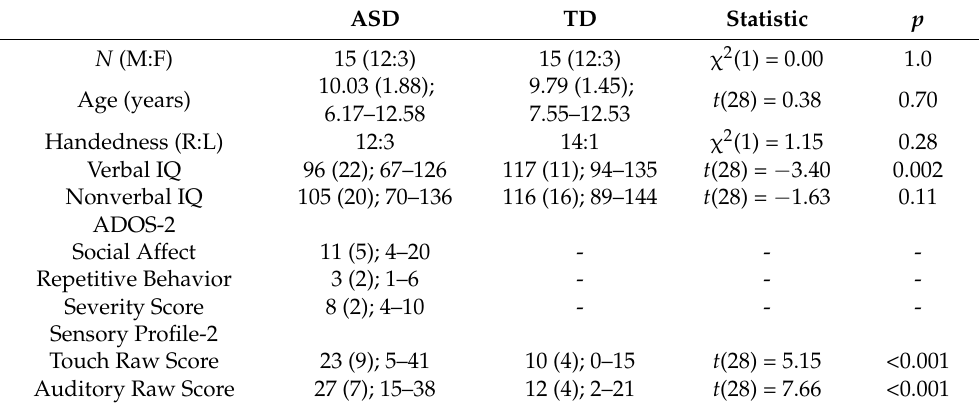
Table 1. Participant